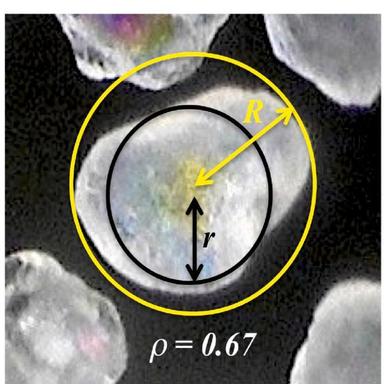
Example of inscribed and circumscribed circles on a single grain of AFS 50–70 sand. The particle in the photomicrograph is 430 μm in maximum length (=2R). In Fig. 3, ρ = 0.67 would correspond to a rounded particle with low sphericity.